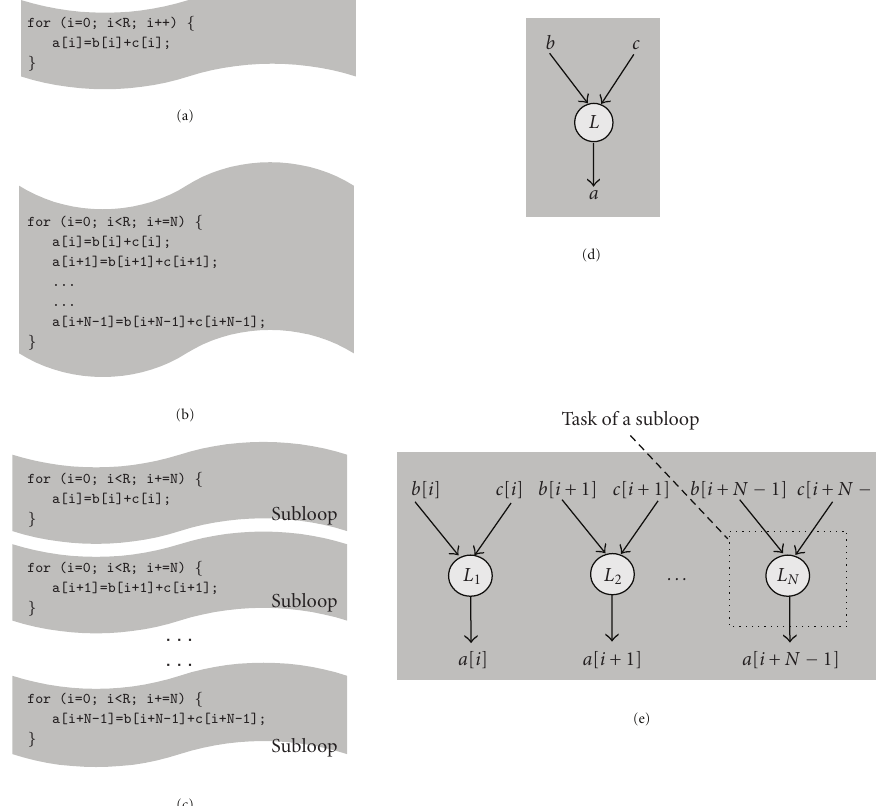
Figure 1: Examples showing various notations: (a) Loop. (b) Unrolled loop. (c) Obtained loop after fission. (d) Task graph representing the original loop, where the loop is a node L in the graph. (e) Task graph representing the loops after